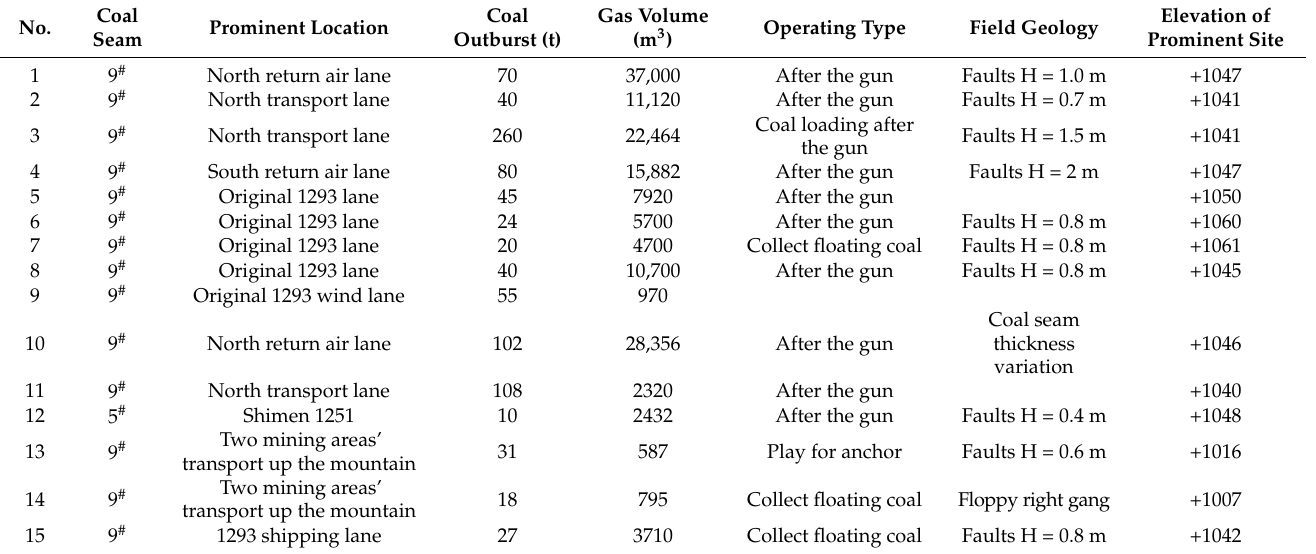
Table 1. Statistics of Coal and Gas Outburst in H Coal Mine.